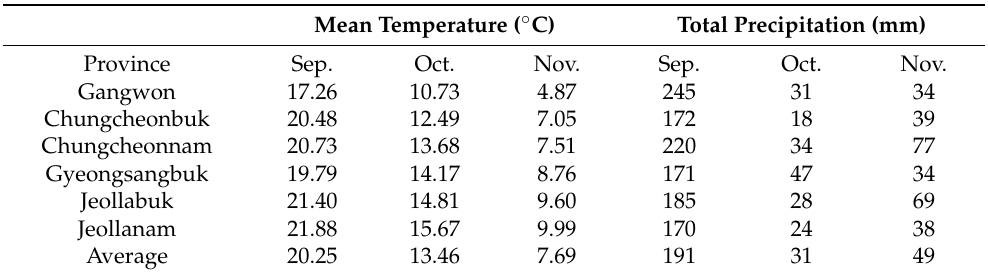
Table 2. Mean temperature and total precipitation of September, October, and November in all six provinces in South Korea. The values were averaged over locations conducted in each province, and for the years